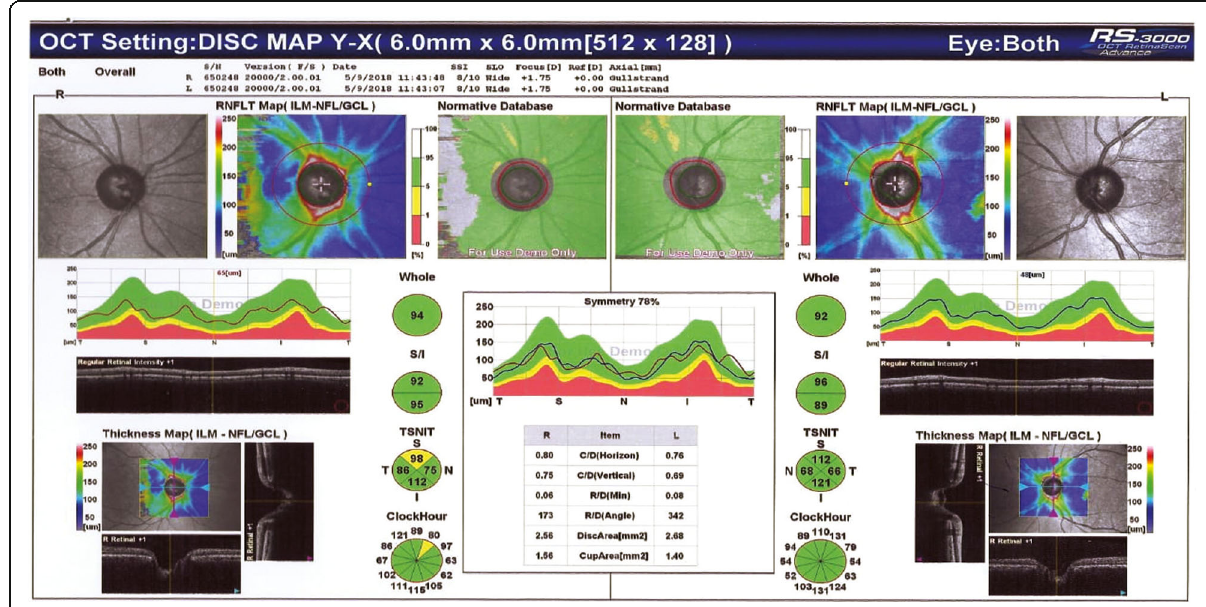
Fig. 1 Outprint of optic disc cube scan by NIDEK RS-3000 Advance machine. The whole thickness map (Whole). The quadrants map (TSNIT). The RNFL thickness is outside the normal limit in the right eye (superior